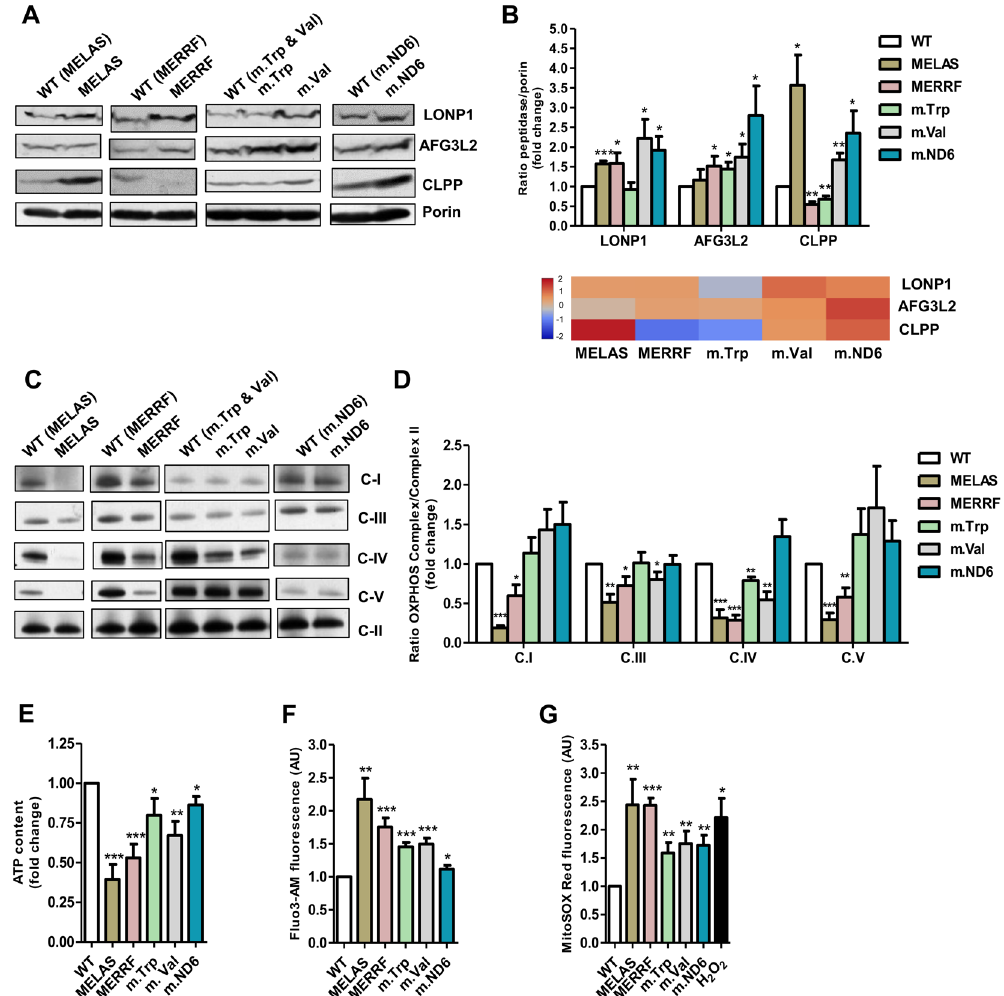
Figure 1. Altered mitochondrial features in cybrid cells carrying MELAS, MERRF, m.5514 A > G (mt- tRNA Trp ), m.1643A > G (mt-tRNA Val ), and m.14487 T > C (ND6) mutations. ( A ) Representative western blot of LONP1, AFG3L2 and CLPP peptidases in mutant and wild type (WT) cybrid cells. The membrane was also probed with porin as a loading control. Full-length western blots and lower-exposure blots of porin are included in supplementary information. ( B ) Densitometric analysis of LONP1, AFG3L2 and CLPP normalized to porin and represented as fold change relative to WT (top). Quantitative data are from at least three independent experiments. Results from this analysis are also shown as a heatmap (bottom). The color and the corresponding value in log 2 scale are depicted on the left. ( C ) Representative Blue Native-PAGE of OXPHOS complexes in mutant and WT cybrid cells. Full-length blots and lower-exposure blots for those with high contrast are included in supplementary information. ( D ) Densitometric analysis of OXPHOS complexes normalized to complex-II (loading control) and represented as fold change relative to WT. ( E ) Cellular ATP determination in mutant and WT cybrid cells. ( F and G ) Determination of Ca 2 + ( F ) and ROS ( G ) by flow cytometry in mutant and WT cybrid cells with Fluo-3 and MitoSOX Red, respectively. All data are the mean ± SEM of at least three different experiments. Differences from WT values were found to be statistically significant at * p < 0.05, ** p < 0.01 and *** p <